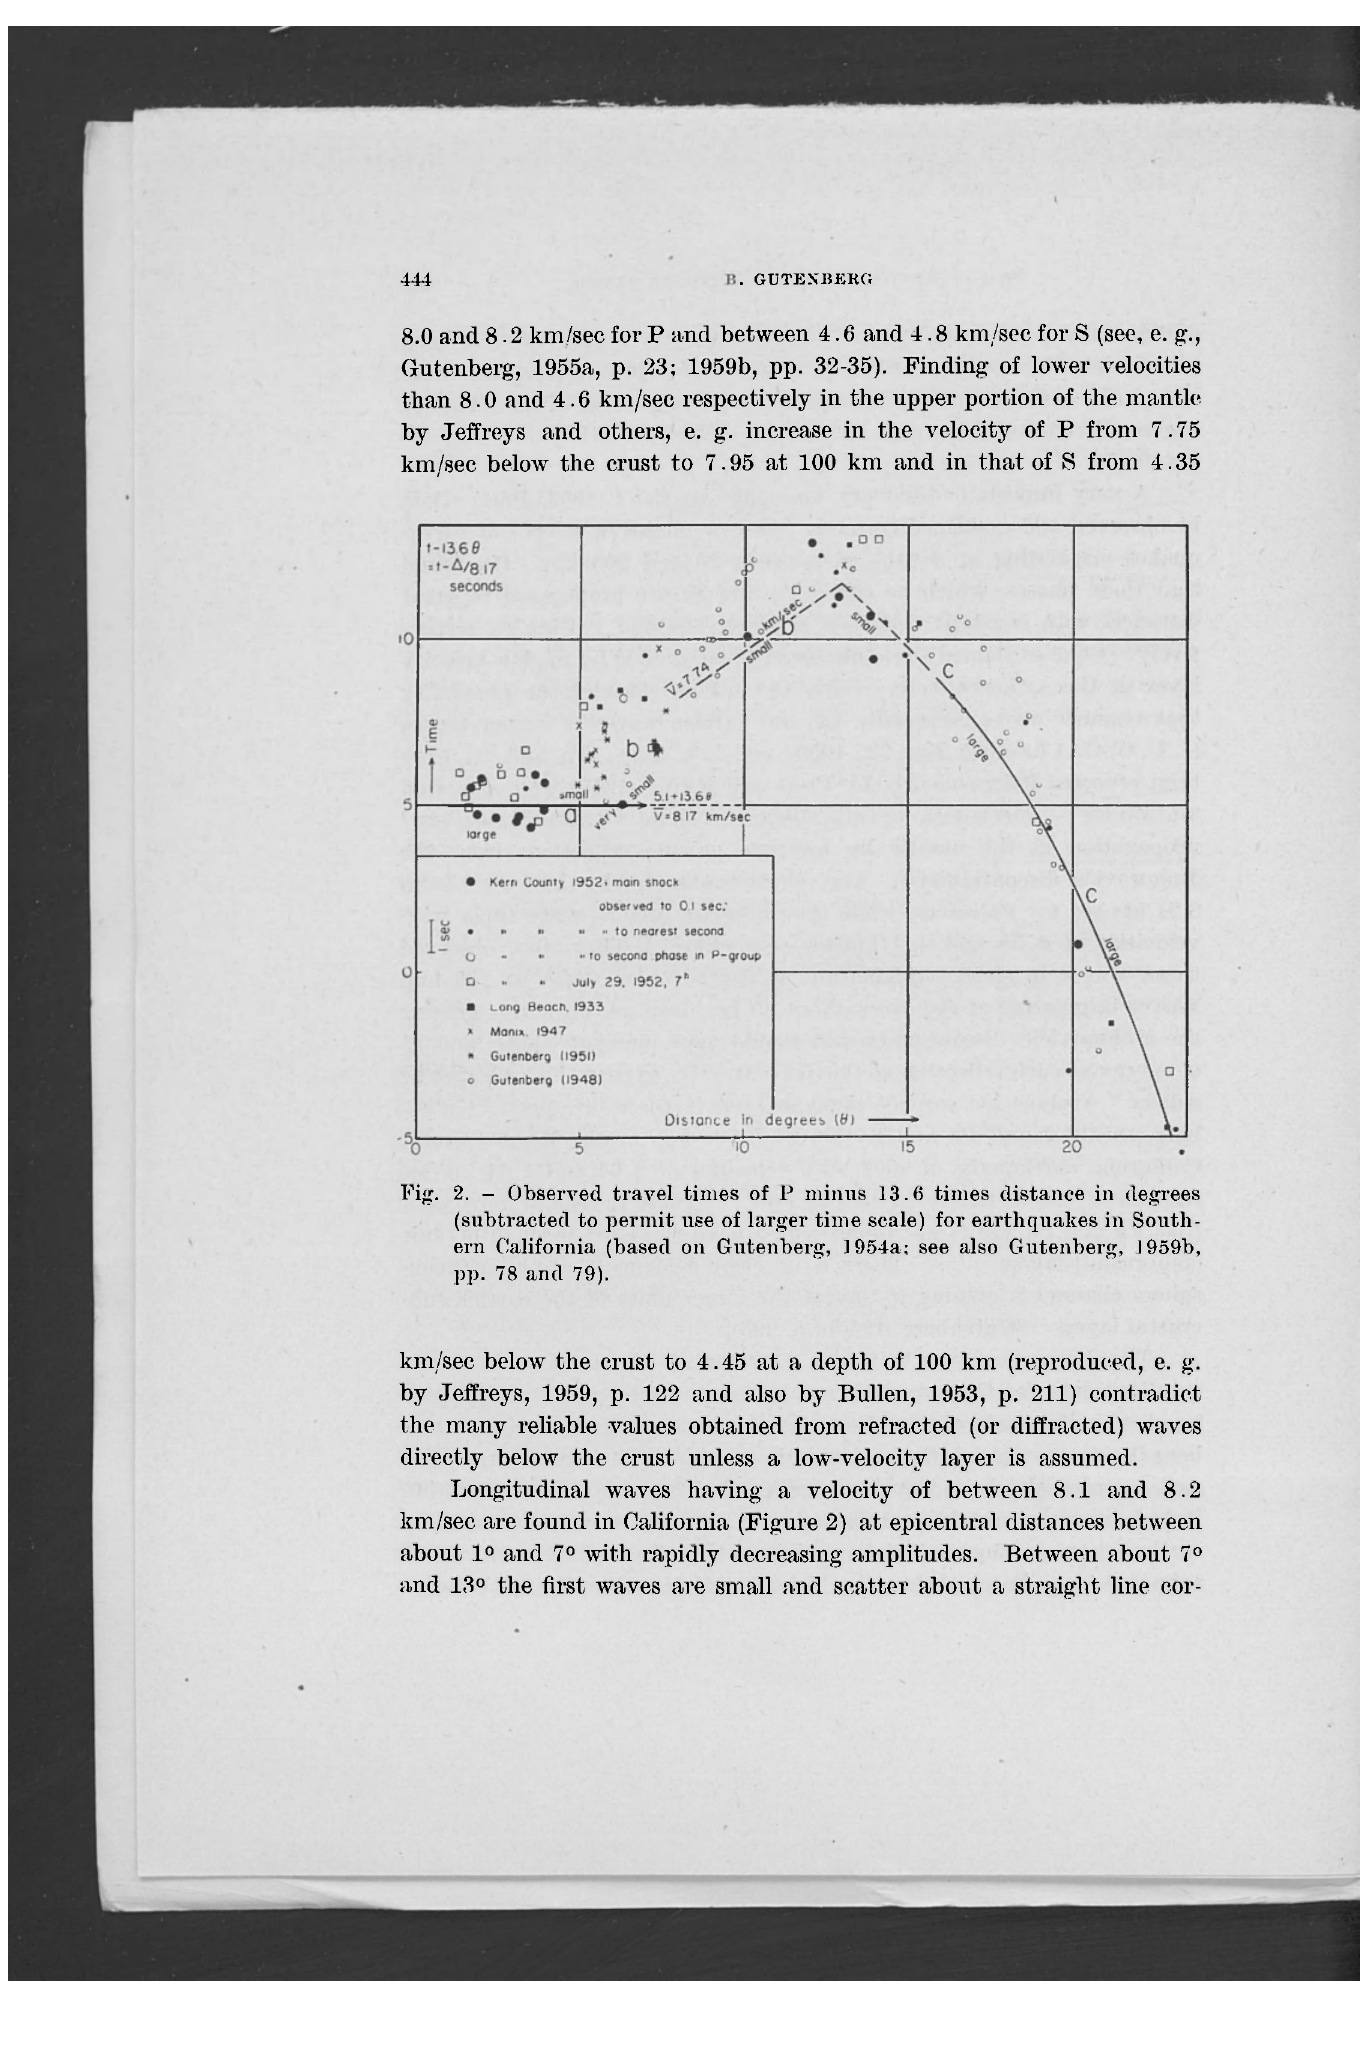
Fig. 2. - Observed travel times of P minus 13. G times distance in degrees (subtracted to permit use of larger time scale) for earthquakes in South- ern California (based on Gutenberg, ]954a; see also Gutenberg, I959b, pp. 78 and